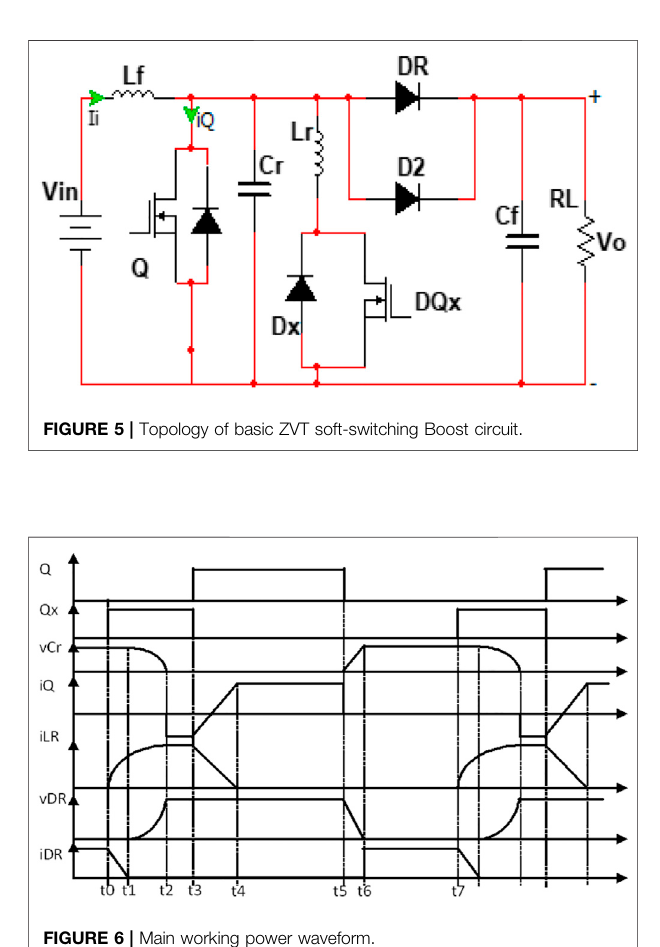
FIGURE 6 | Main working power